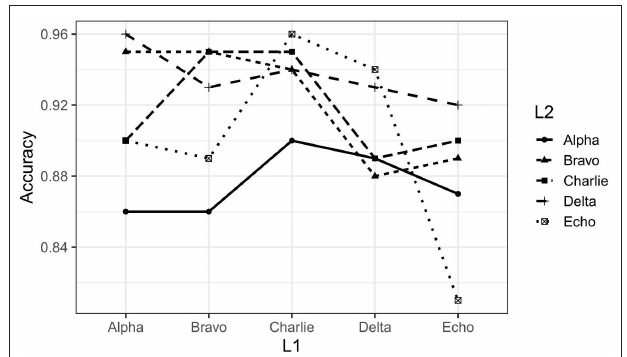
FIGURE 2 | Summary of parsing accuracy for monolingual and bilingual models. Lines connect the results for outputs produced in the same target language. Datapoints where L1 and L2 are the same represent the monolingual models; datapoints where L1 and L2 are not the same represent bilingual